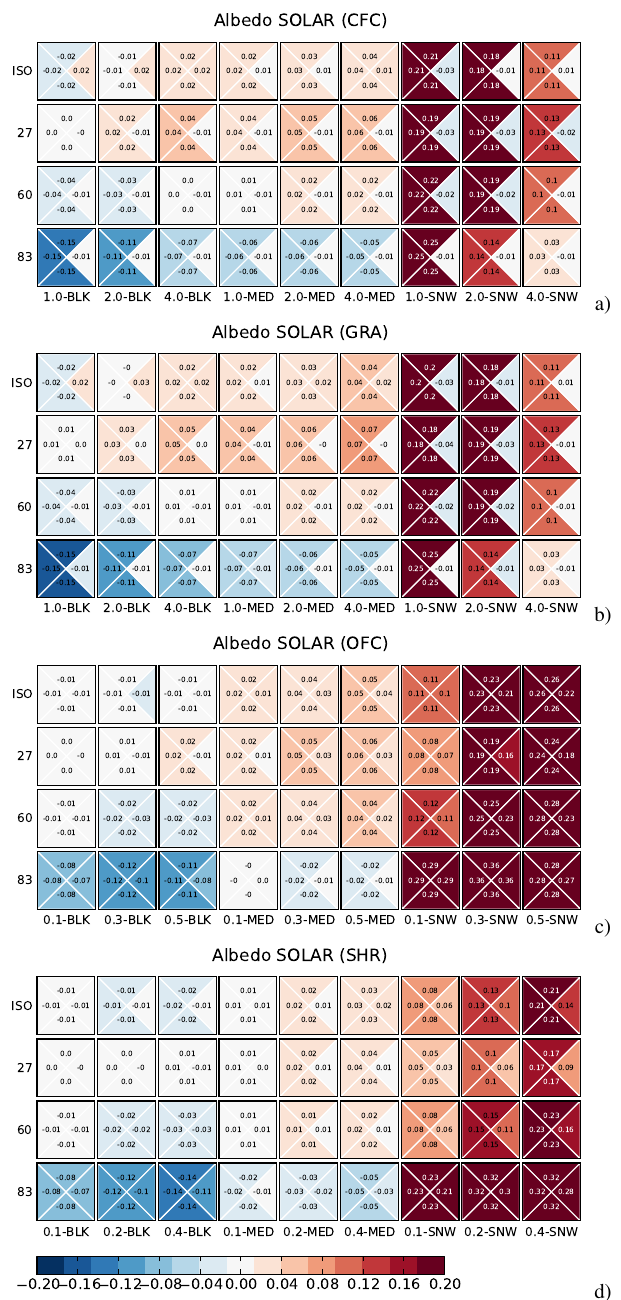
Fig. 5. Deviations of simulated surface albedo from RAMI4PILPS reference solutions ( α model − α ref ) for the solar spectrum ( 0 . 3 ... 4 . 0 µm ). Details of figure are the same as for Figure 3.